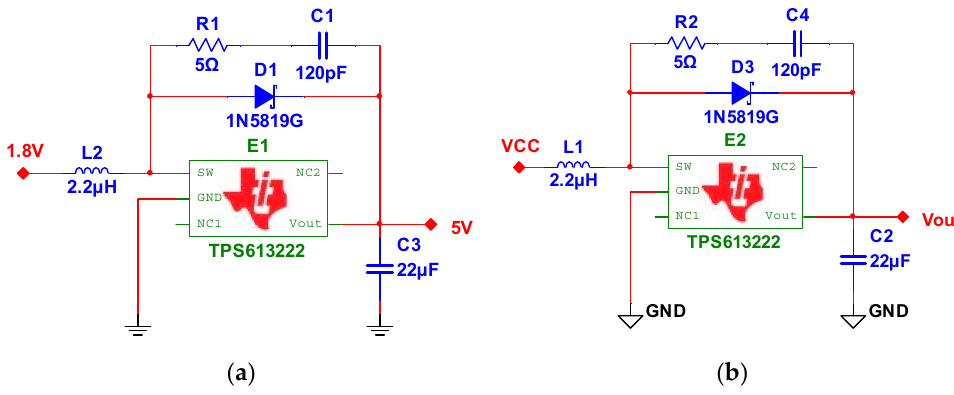
Figure 12. Boost converters: ( a ) to source the microcontroller and the relay; ( b ) to regulate the output voltage of the super capacitors.